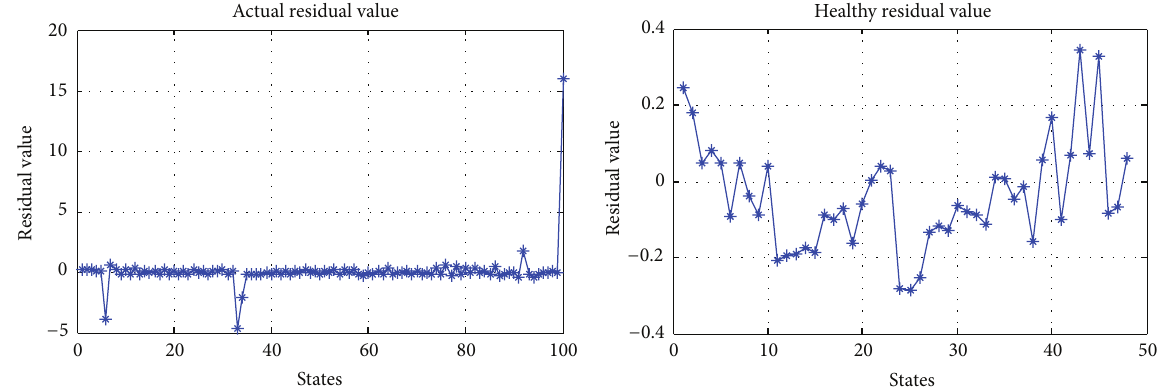
Figure 15: Actual residual value and healthy residual value of 𝑅 𝑒 and 𝑅